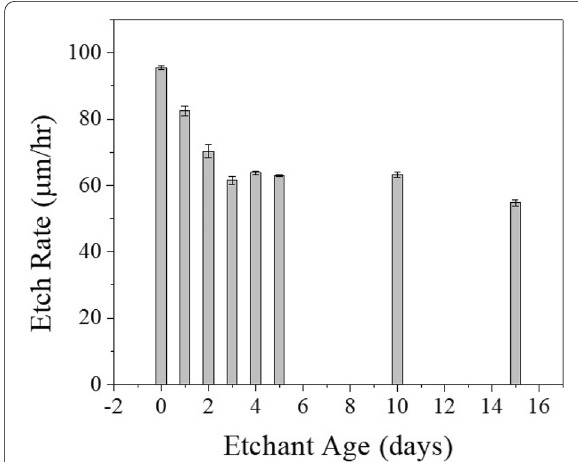
Fig. 2 Effect of aging of 10 M NaOH of Si100}